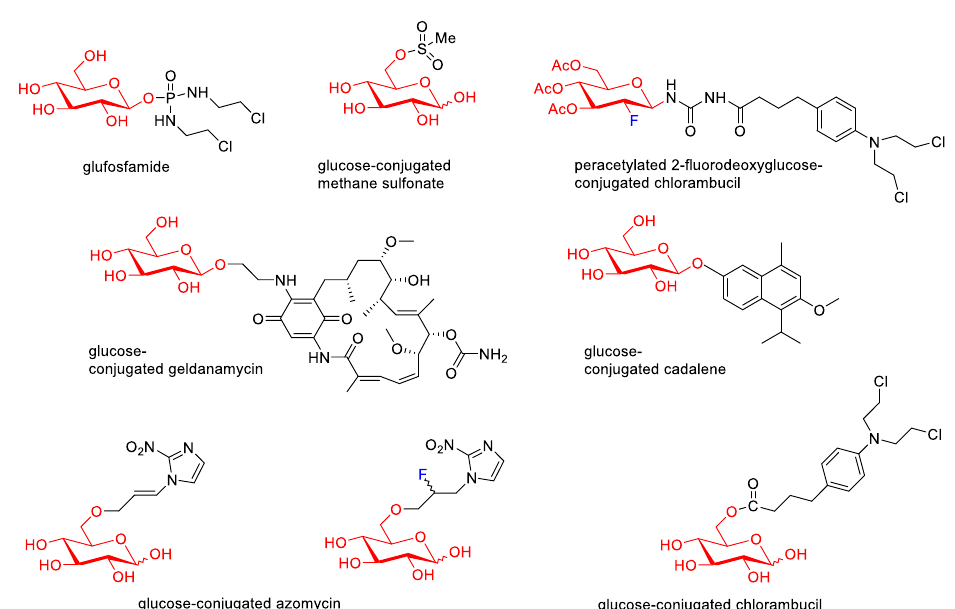
Figure 2. Representative anticancer drug glycoconjugates.